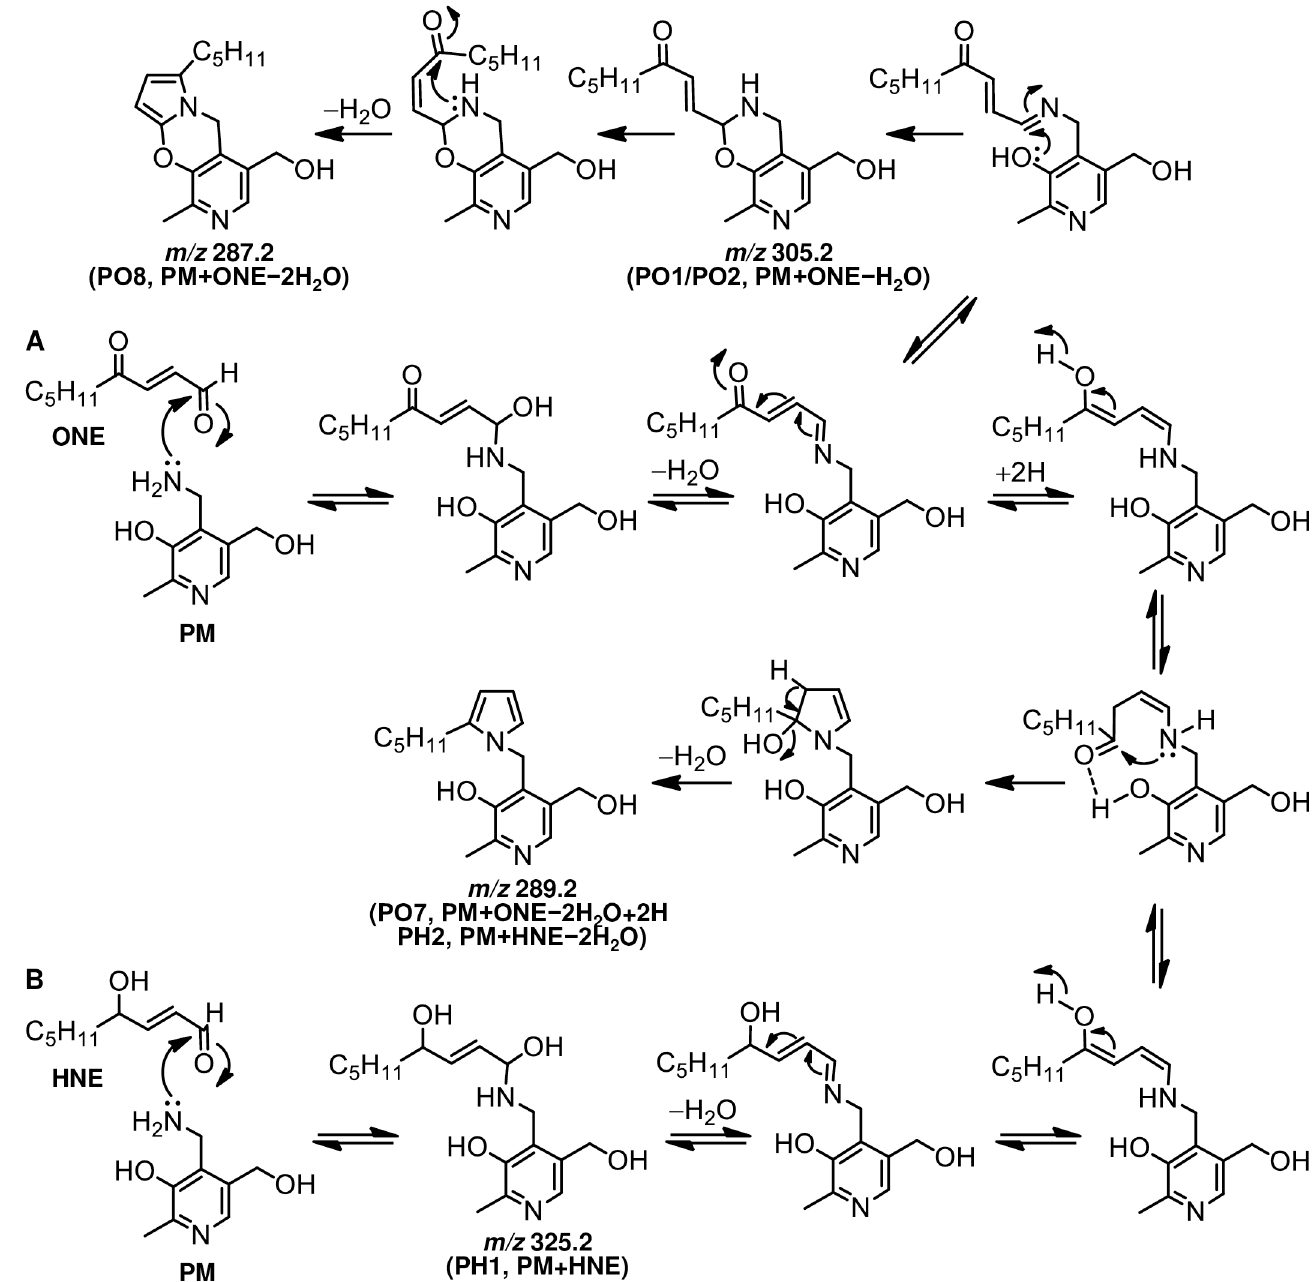
Fig 6. Proposed mechanism for the formation of (A) PM-ONE and (B) PM-HNE adducts from the reaction of PM with ONE or HNE, respectively. examined and contains no amino acid residues that can be modified by ONE. In addition, seven target peptides were selected based on the frequency of their detection and MS intensity. LC/ESI-MS analyses revealed the presence of four PM-ONE adducts (S2 Fig). The products eluting at 26.3 and 29.4 min showed an [M + H] + at m/z 305, corresponding to PO1 and PO2, respectively. The other adducts, which eluted at 36.3 min ([M + H] + ; m/z 289) and 38.9 min ([M + H] + ; m/z 287), corresponded to PO7 and PO8, respectively. The MS peak intensities of